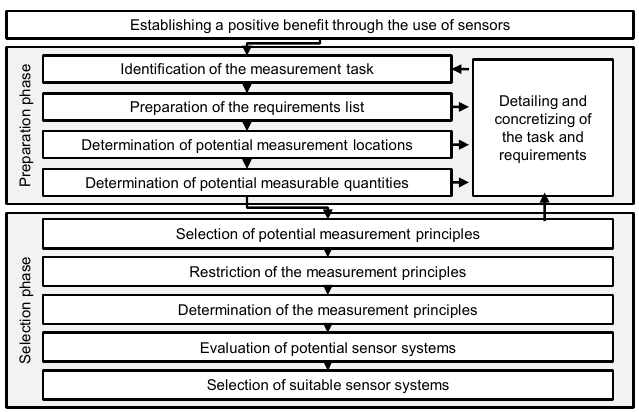
Figure 3. Systematic approach for sensor selection following [25], based on [23].